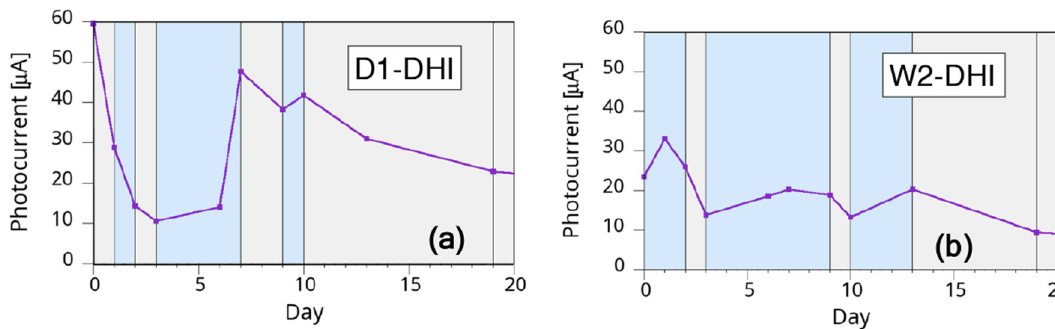
Figure 6. Behavior of PSi:melanin samples when stored in wet (light blue areas) and dry (grey areas) environment for ( a ) D1-DHI sample and ( b ) W2-DHI sample in a timespan of three weeks after